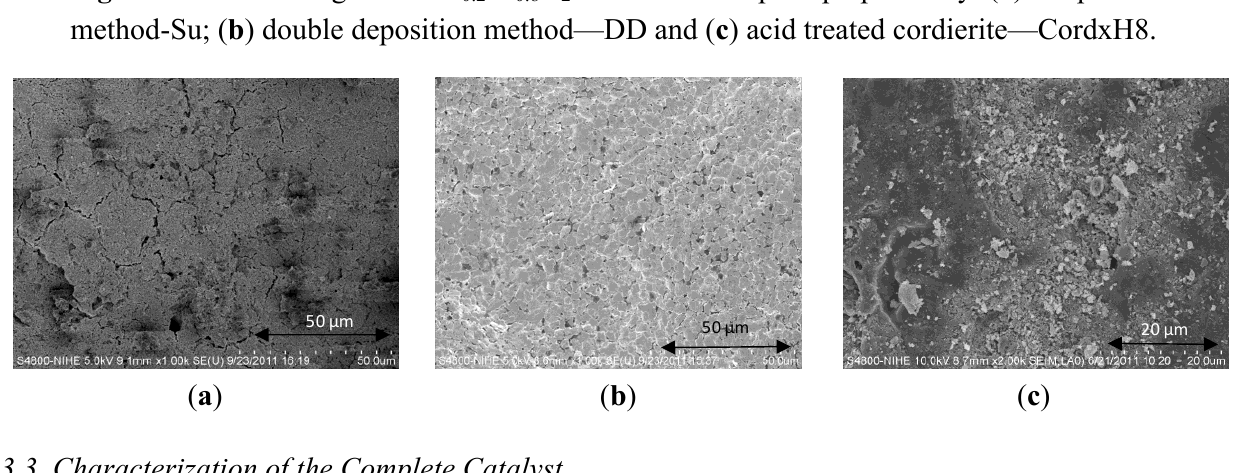
Figure 3. SEM images of Ce